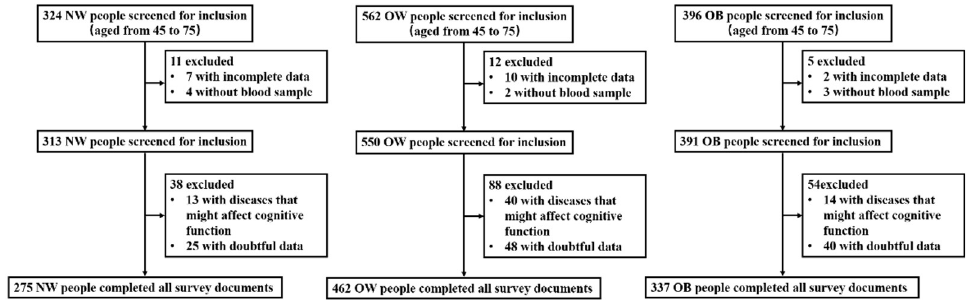
Figure 1. Study flowchart. NW: normal weight group; OW: overweight group; OB: obese group. The participants were classified as normal weight (NW; 18.50 ≤ BMI < 24.00), over-